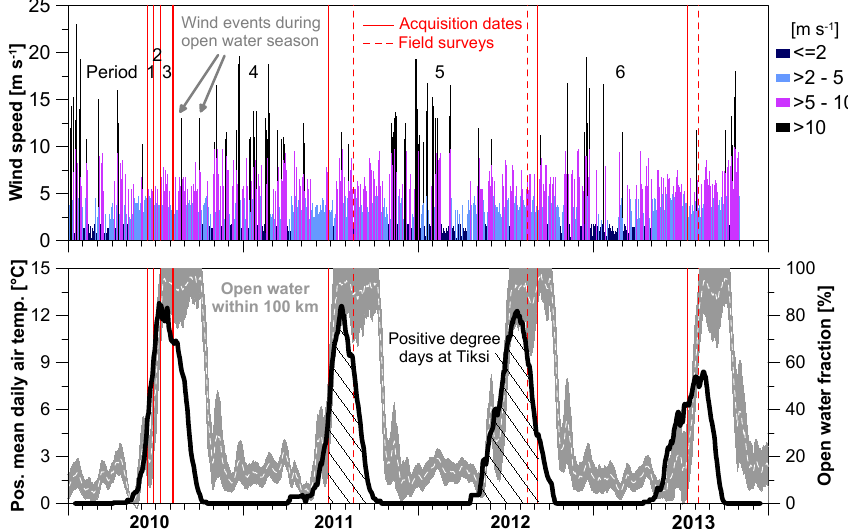
Figure 12. Hydrometeorological data over time; straight-through lines mark satellite image acquisitions, dashed lines topographic surveys during on-site visits, all with uneven distribution. Top: bars of average 6h wind speeds measured in the nearby town of Tiksi. Bottom: seasonal fluctuations of positive mean daily T air at Tiksi (black curve) and open water fraction within a 100km radius around Muostakh Island (white dashed curve, grey standard deviation range), both plotted as a 15-day running mean. Integration under the Tair curve was used as positive degree-day sum for normalisation of observation period specific thermo-denudation rates (shaded area as example for period 5). Note the time shift of positive T air and open water